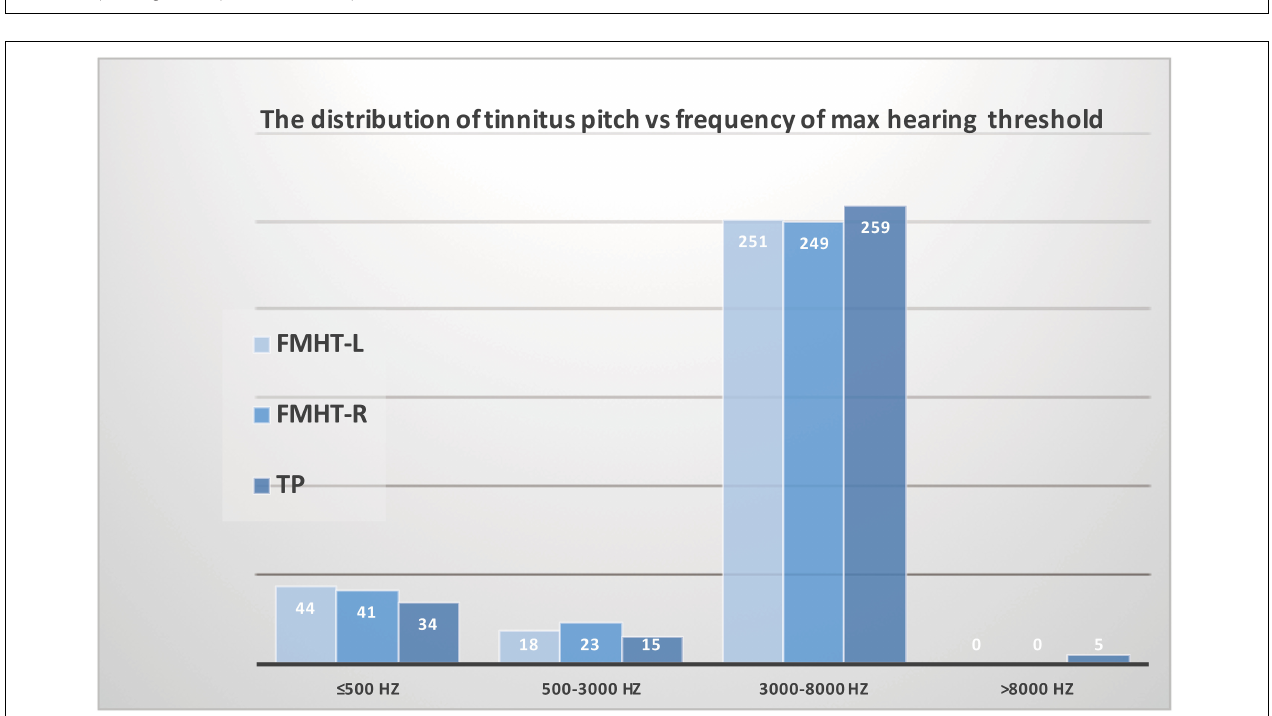
FIGURE 3 | Association between the distribution of tinnitus pitch and the distribution of maximum threshold corresponding frequency in patients with tinnitus and normal hearing. The distribution of threshold-elevated frequencies in both the left ears and right ears was consistent with the distribution of dominant tinnitus pitch.